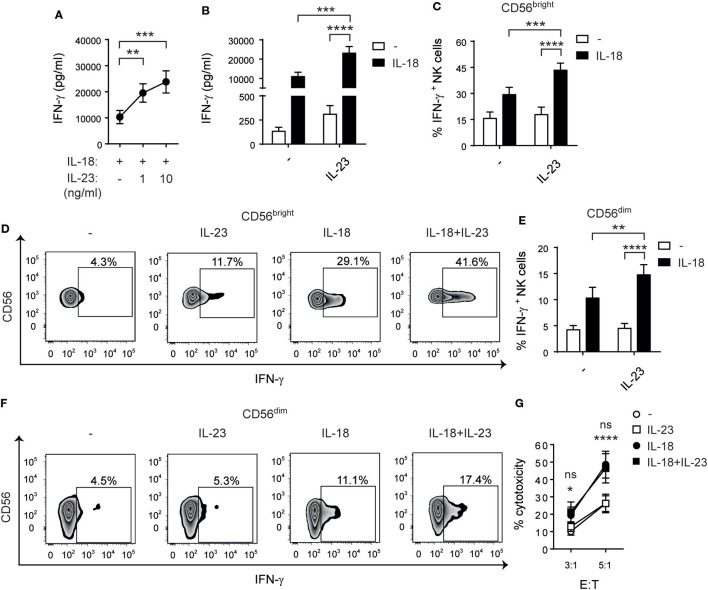
Interleukin (IL)-23 synergizes with IL-18 for IFN-γ production but not for cytotoxicity. (A) IFN-γ secretion by natural killer (NK) cells cultured for 24 h with IL-18 in the absence (−) or in the presence of 1 or 10 ng/ml of IL-23; n = 14. (B) IFN-γ secretion by NK cells cultured for 24 h in the absence (−) or in the presence of IL-23, IL-18, or IL-23 and IL-18 (IL-18 + IL-23), all at 10 ng/ml; n = 17. (C–F) Percentage of IFN-γ producing CD56bright
(C,D) and CD56dim
(E,F) NK cells after culture in the absence (−) or in the presence of IL-23, IL-18, or IL-23 and IL-18 for 24 h; n = 12. Representative zebra plots are shown in (D,F). (G) Cytotoxic activity of NK cells previously cultured overnight in the absence (−) or in the presence of IL-23, IL-18, or IL-23 and IL-18 against Raji cells at different E:T ratios; n ≥ 6. Mean ± SEM are shown. ns, not significant; *p < 0.05; **p < 0.01; ***p < 0.001; ****p < 0.0001; one-way ANOVA with repeated measures and Bonferroni’s post hoc test (A) and two-way ANOVA with repeated measures and Bonferroni’s post hoc test (B,C,E,G). The interaction p values (synergism) were: p = 0.0038 (B), p = 0.0053 (C), and p = 0.0110 (E). (G) *NK cells stimulated with IL-18 + IL-23 vs IL-23; ns: IL-18 + IL-23 vs IL-18.